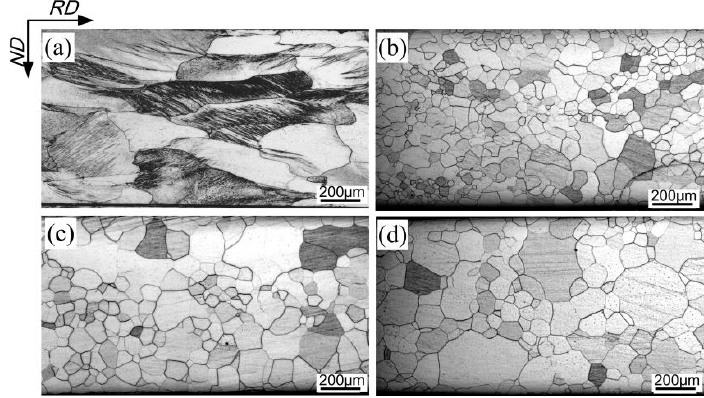
Figure 4. Microstructure of sheets processed by two-stage cold rolling. ( a ) First cold-rolled sheet; ( b ) 900 °C intermediate-annealed sheet; ( c ) 1000 °C intermediate-annealed sheet and ( d ) 1100 °C intermediate-annealed sheet.